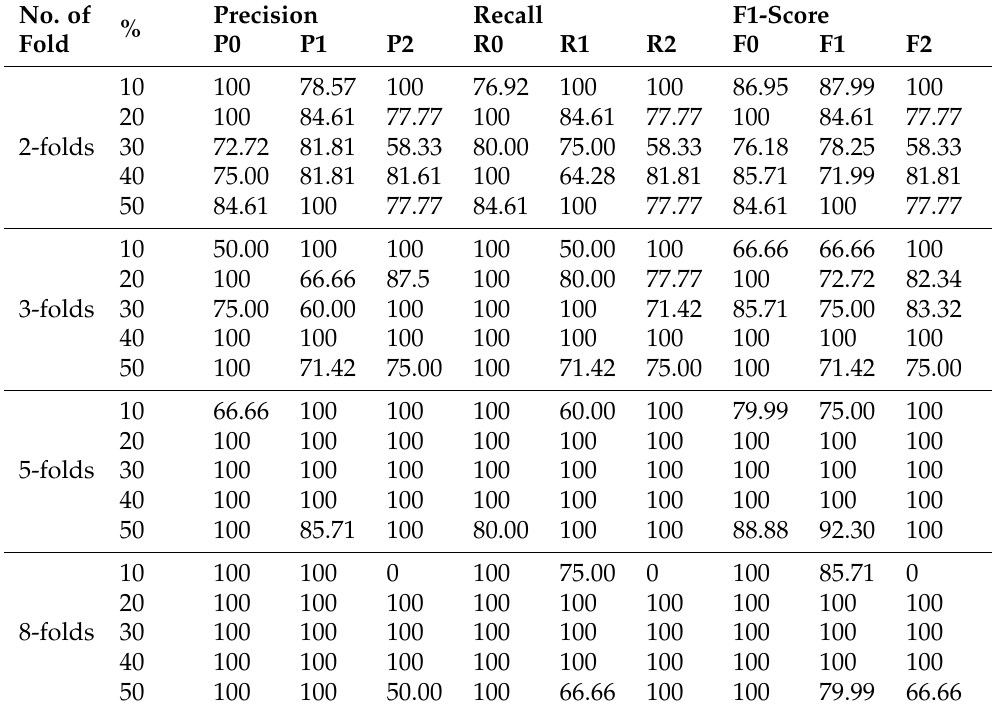
Table 2. Reference frame without segmentation.